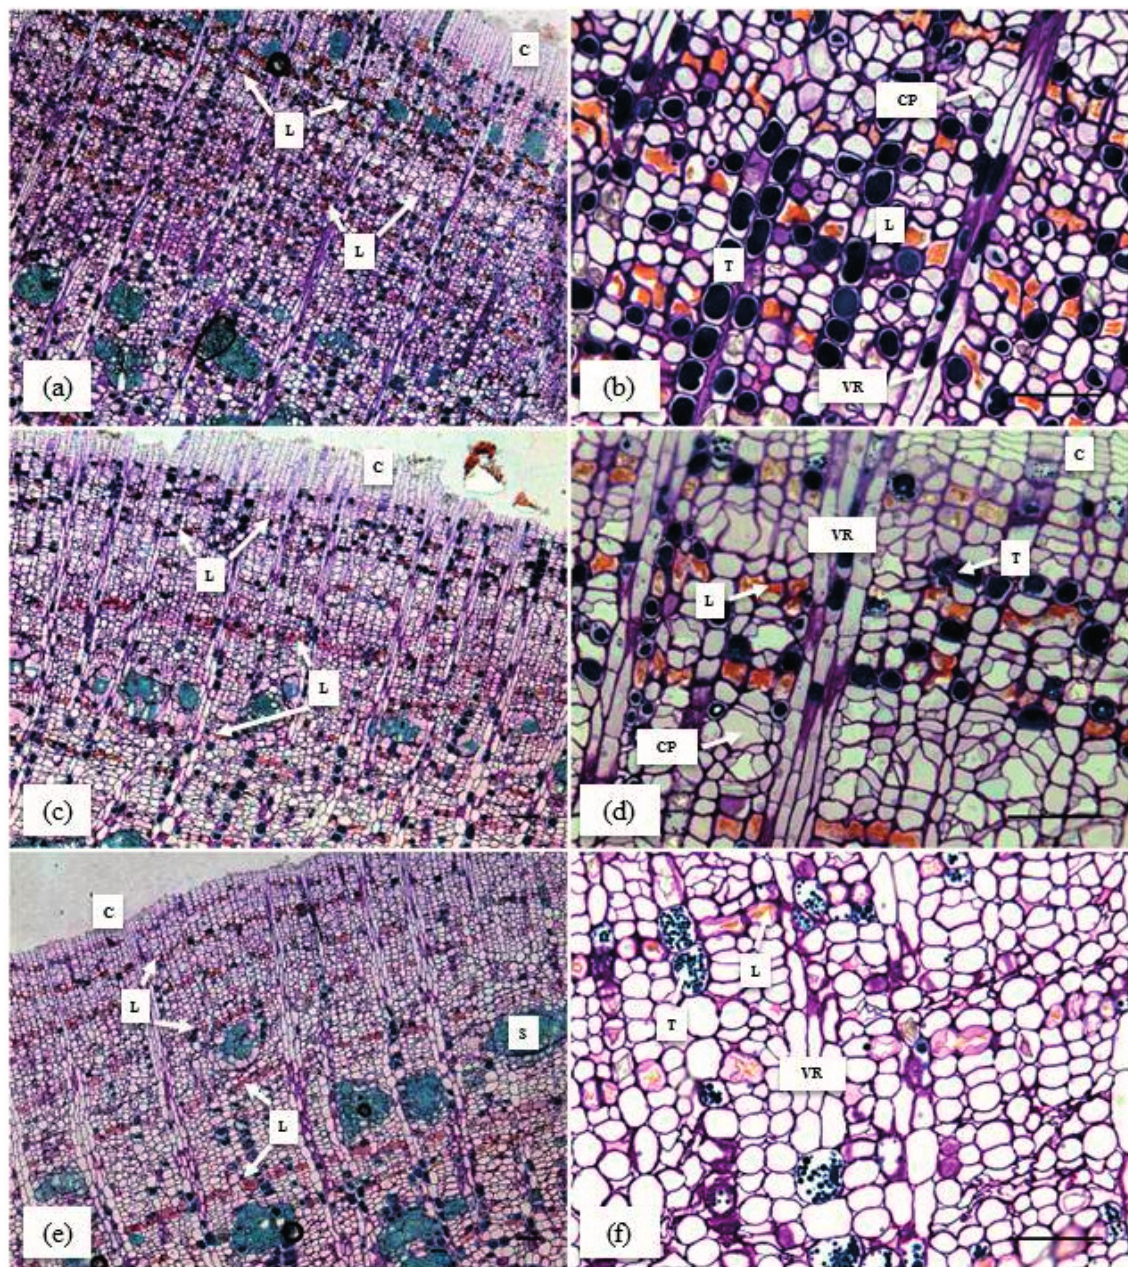
Figure 7. Histo-cytological description of bark tissues from healthy and Tapping Panel Dryness (TPD)-affected trees for high latex metabolism clone PB 260. The histological sections were stained with Oil Red O. Cross-sections of healthy bark ( a , b ); reactive oxygen species (ROS)-TPD bark ( c , d ); and brown bast (BB)-TPD bark ( e , f ); at different magnifications (5× and 20×, respectively) were annotated: C. cambium; L. Laticiferous cells; P. conducting phloem; VR. vascular ray; T. tannin cells; S. sclereid (stone